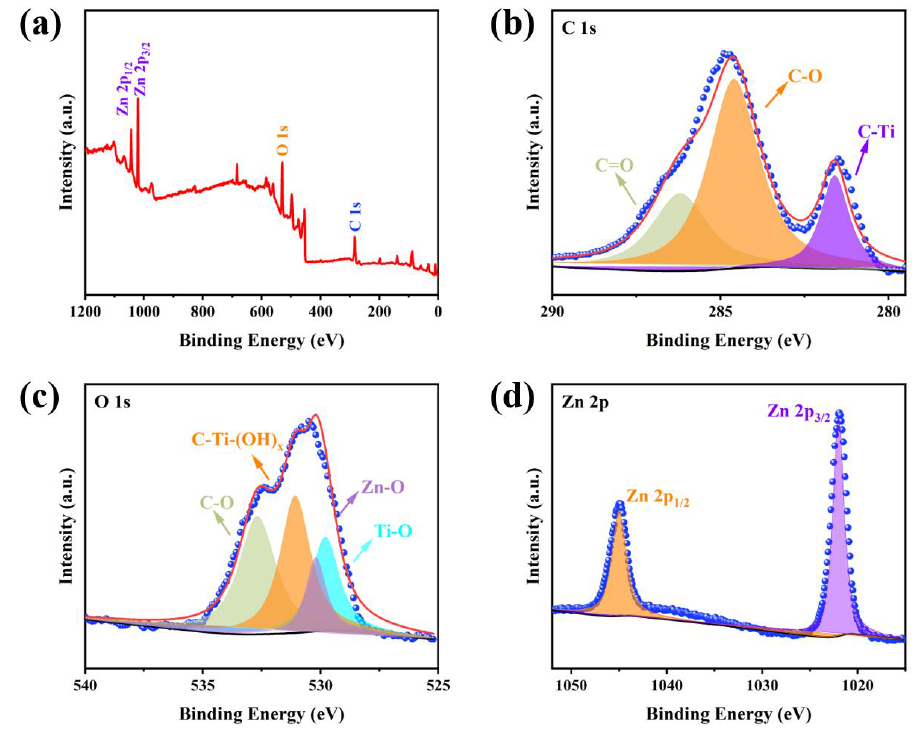
Figure 3. XPS spectra of PET/ZnO@MXene composite fabric, ( a ) full-survey XPS spectrum, ( b ) C 1s, ( c ) O 1s, and ( d ) Zn 2p high-resolution spectrum.